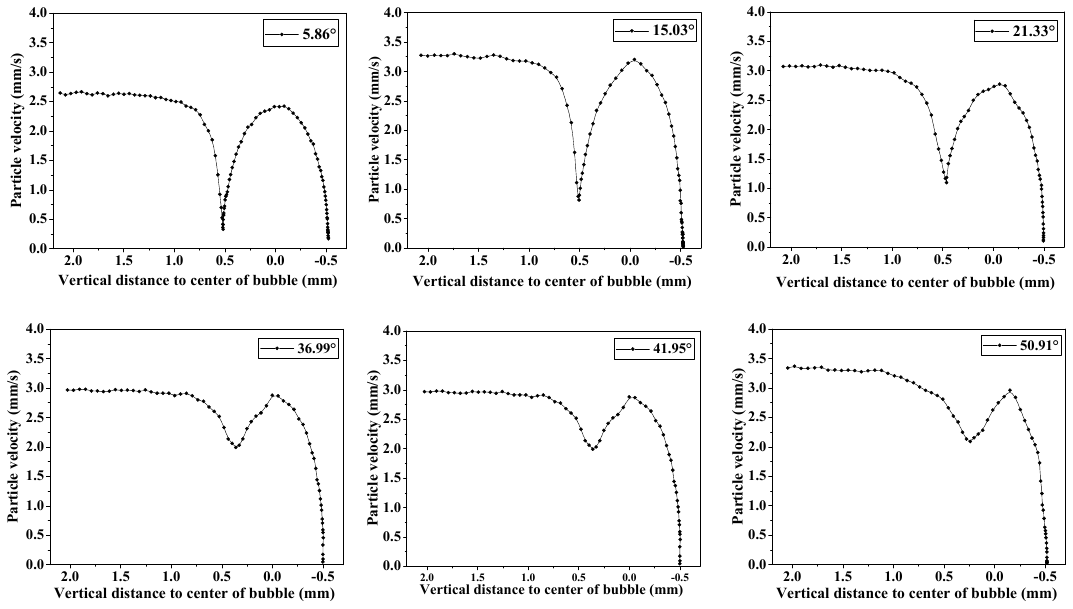
Figure 9. Diagram of particle velocity.